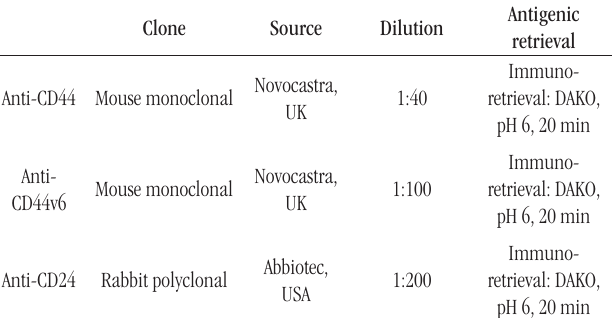
taBLE 2 − Antibodies and antigen retrieval techniques Clone